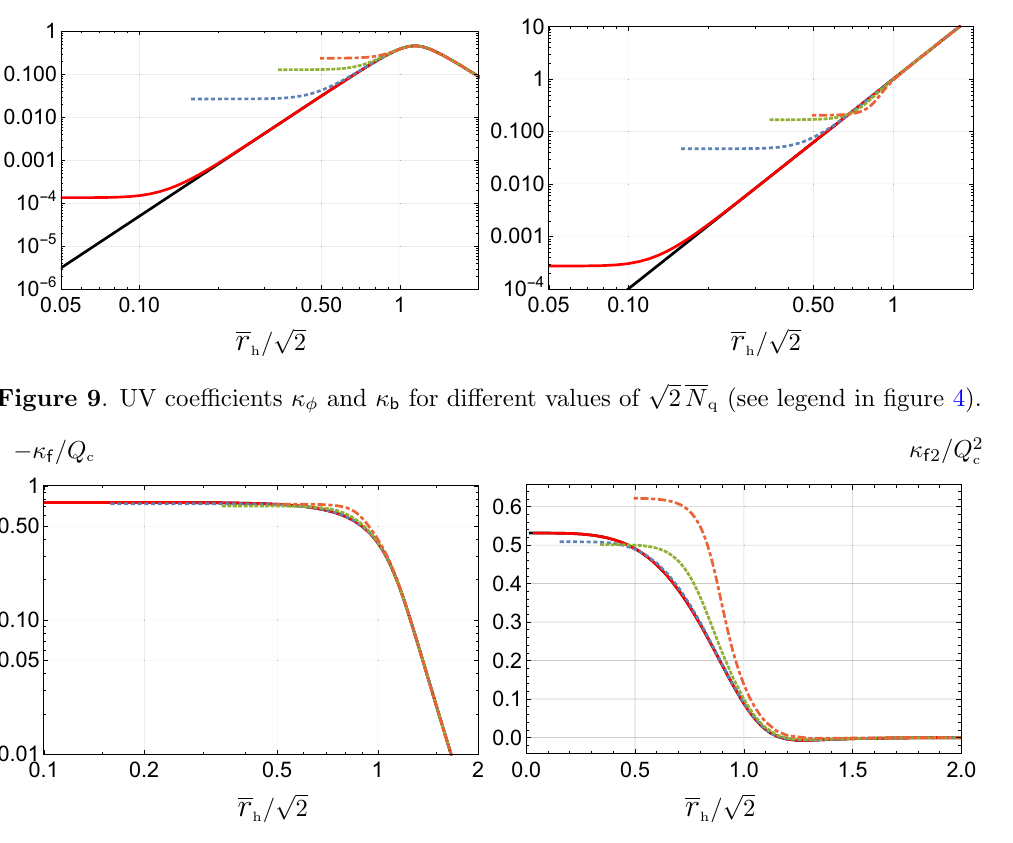
and κ for different values of √ 2 N f f 2